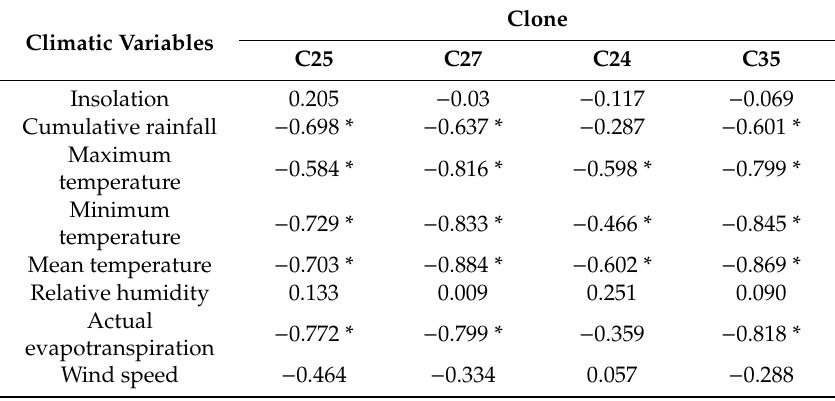
Table 1. Correlation coe ffi cients between the climatic variables and candeia rust severity, caused by Puccinia velata in September 2016 to August 2017. Lavras, Minas